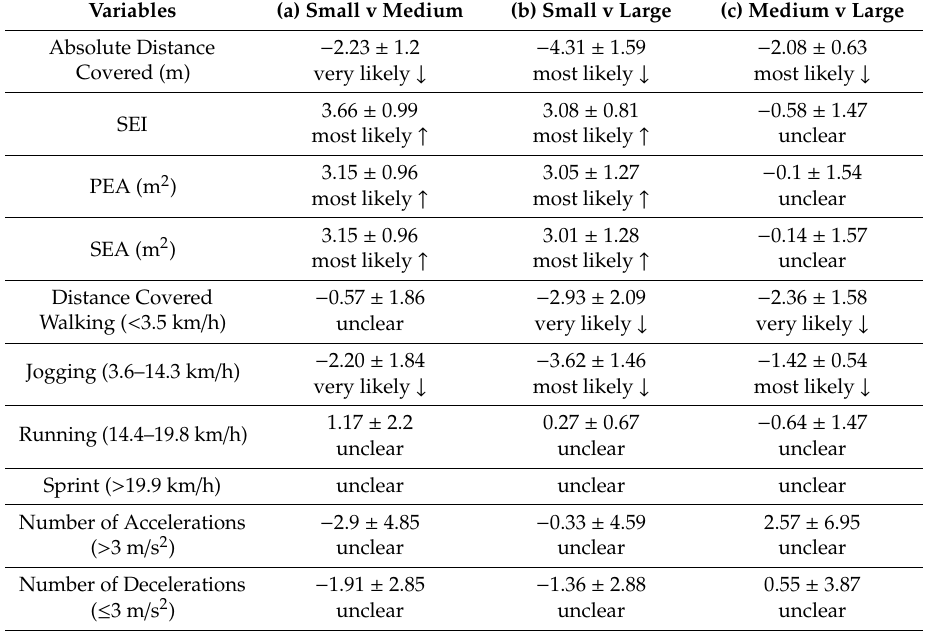
Table 2. Di ff erence in means (Standarized; ± 90% CL) and uncertainty in the true di ff erences comparisons among SSG pitch